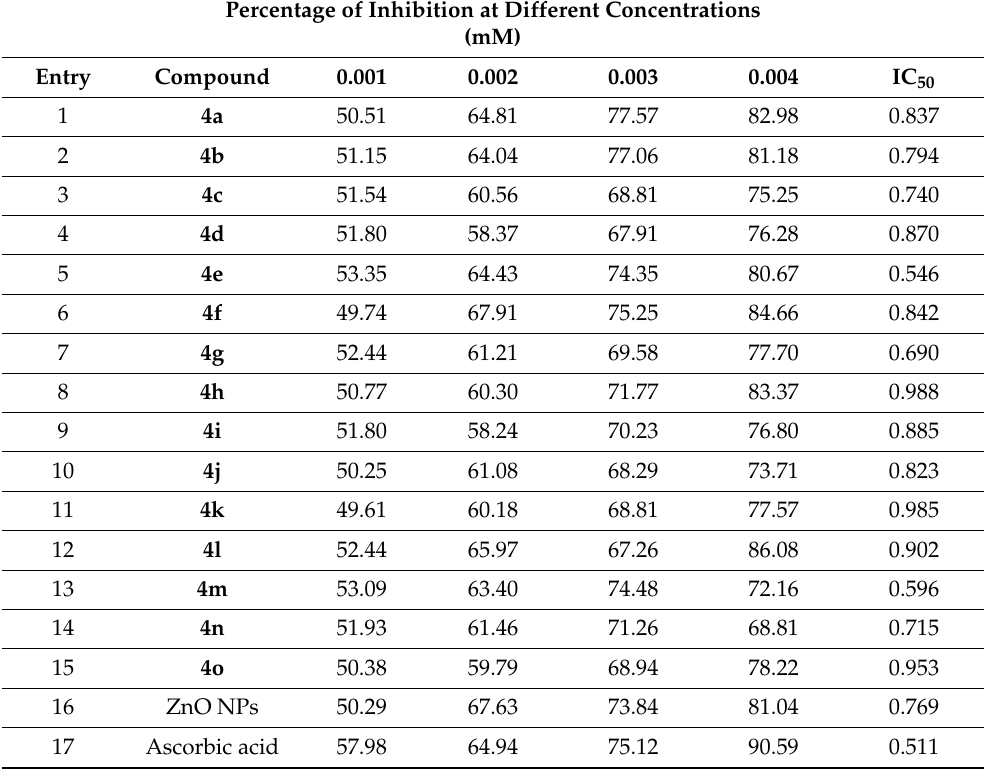
Table 4. Percentage of inhibition and IC 50 values of compounds 4a – 4o